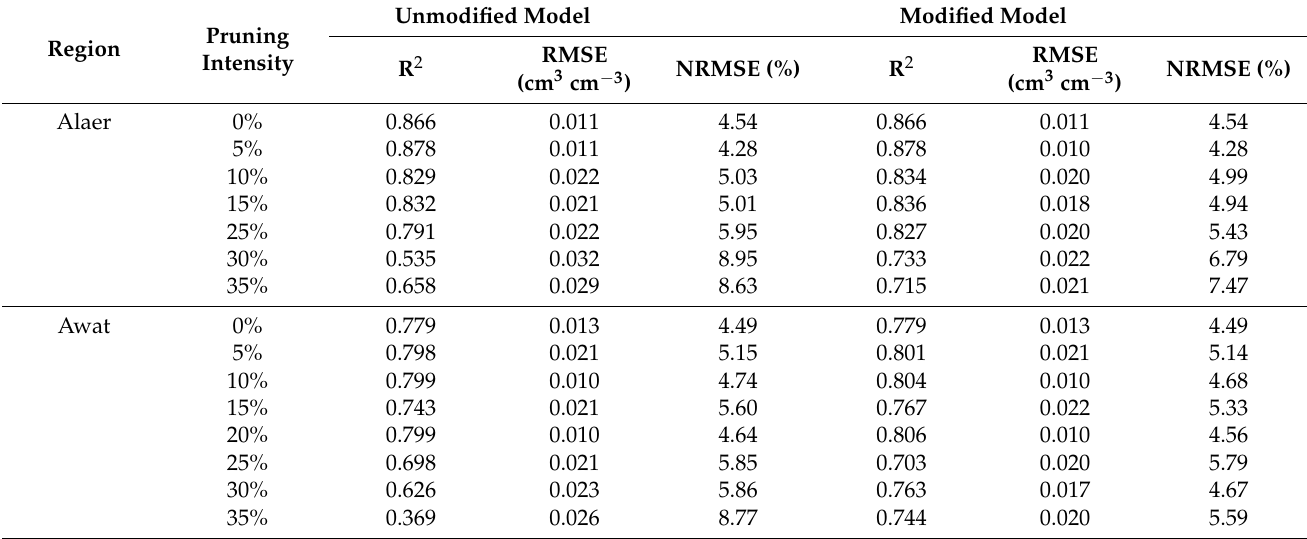
Table 4. Simulated SM Validation for different treatments.